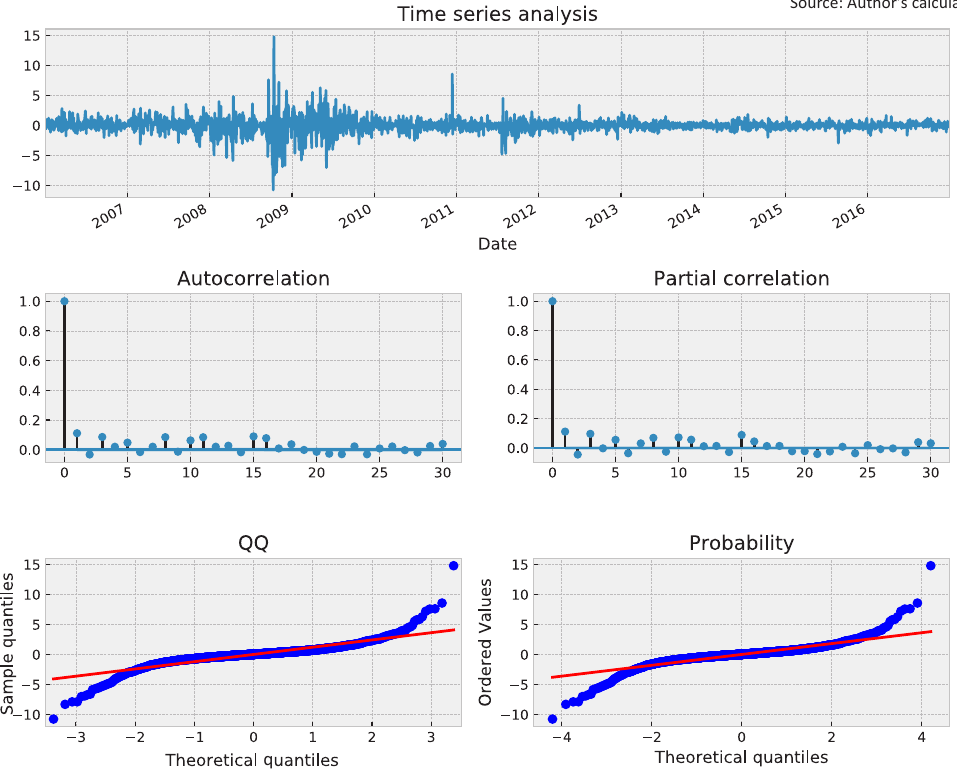
Figure 1. CROBEX autocorrelation test results